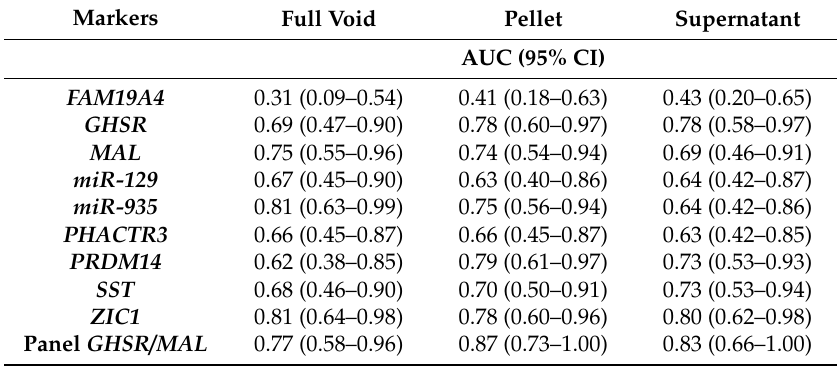
Table 3. Area under the curve values for the nine methylation markers and marker panel GHSR / MAL , in full void, urine pellet and supernatant.